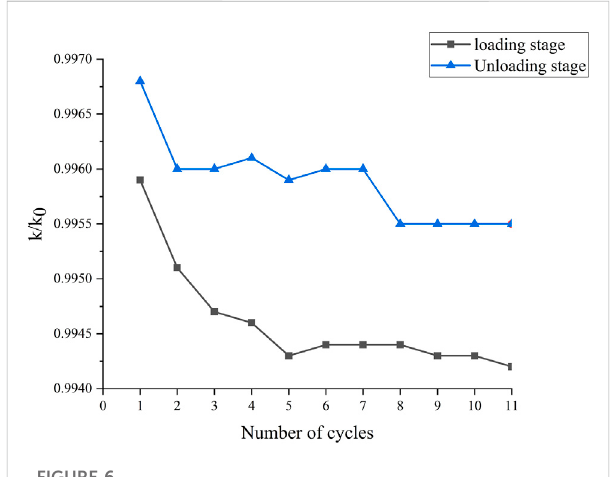
FIGURE 6 Relationship between permeability ratio and cycle